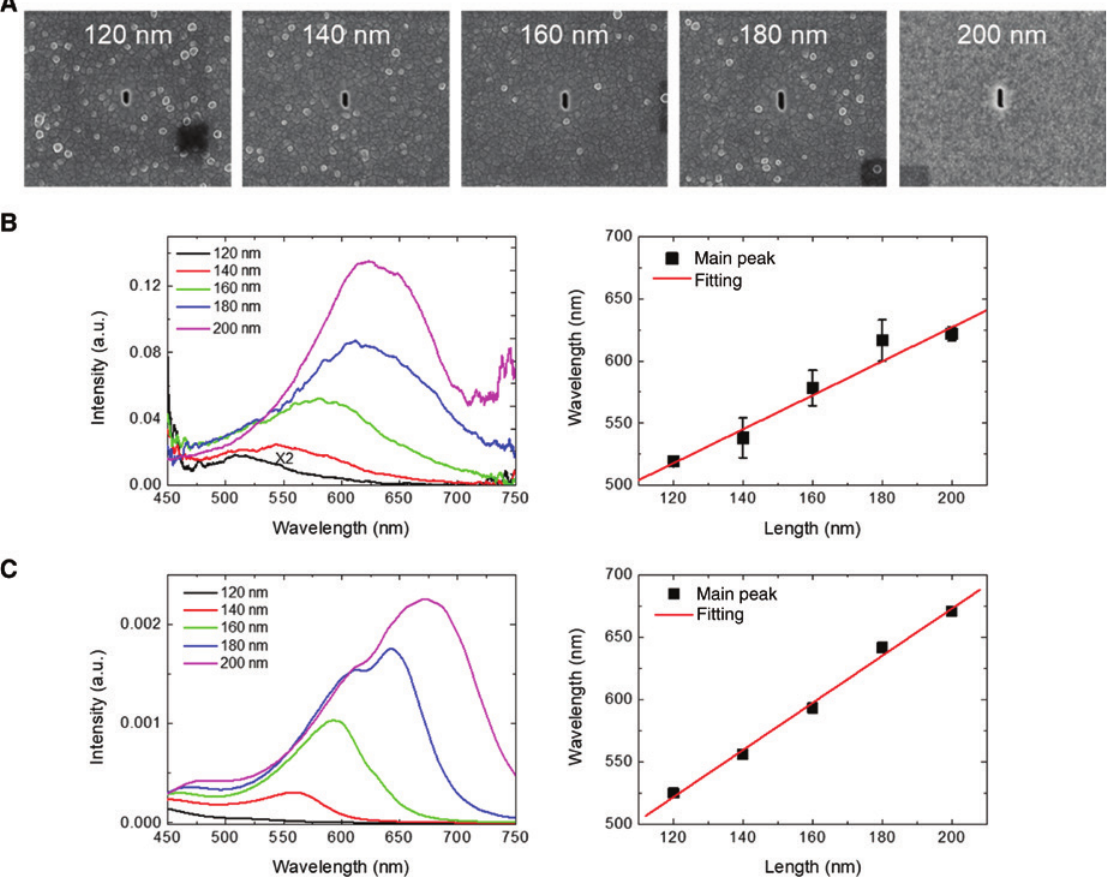
Figure 3: Resonance property of metallic nanoslots. (A) Scanning electron microscope (SEM) images of metallic nanoslots of different lengths and (B) transmission spectra measured in the fabricated nanoslots. (Left) Wavelengths of the main peaks in the measured transmissions were redrawn as functions of the slot length and (Right) red line shows the linear fitting. (C) Transmission spectra of the nanoslots calculated by 3D-FDTD. (Left) Wavelengths of the main peaks in the calculated transmissions were redrawn as functions of slot length and (right) ted line shows the linear